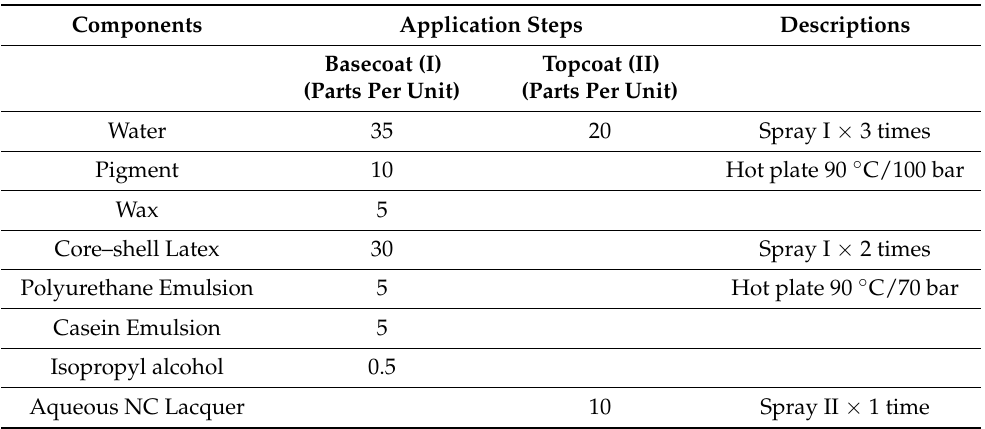
Table 2. The finishing formulation applied on the